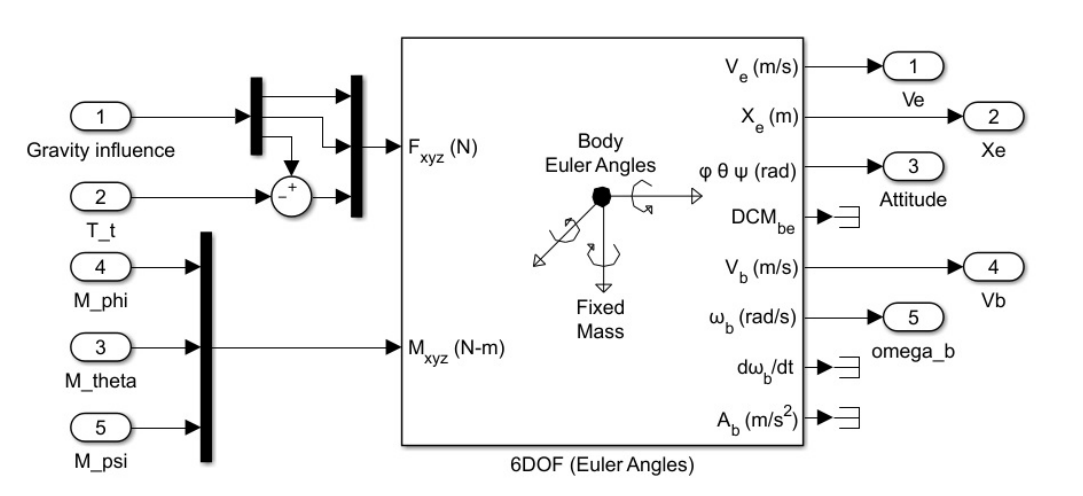
Figure 7. Simulink/Aerospace Blockset 6DOF